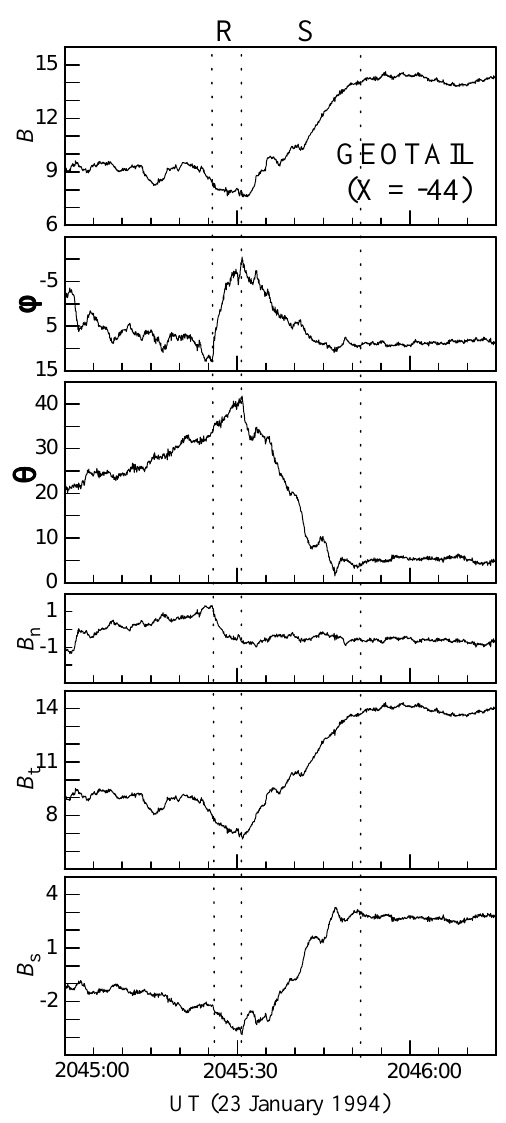
Fig. 6. A double discontinuity was observed on 12 January 1994 from Geotail spacecraft at the plasma sheet-lobe boundary. The S- layer is accompanied by an adjoining rotational discontinuity layer (R-layer) on the postshock side.